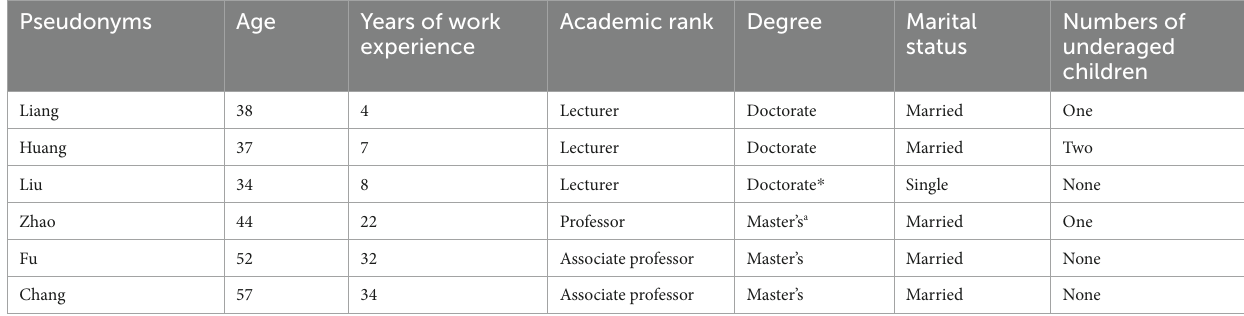
TABLE 1 The participants.